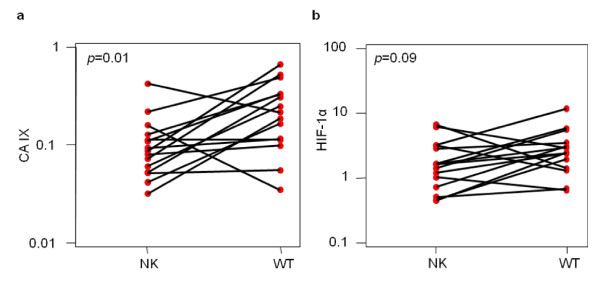
CA IX and HIF-1α protein levels in total cell lysates of 15 Wilms tumours (WTs) and 15 matched-paired uninvolved kidney (NK) samples as quantified by ELISA. a) CA IX is significantly higher in WTs. b) HIF-1α is up-regulated in WTs compared to paired NKs. Paired results are plotted on a log scale.